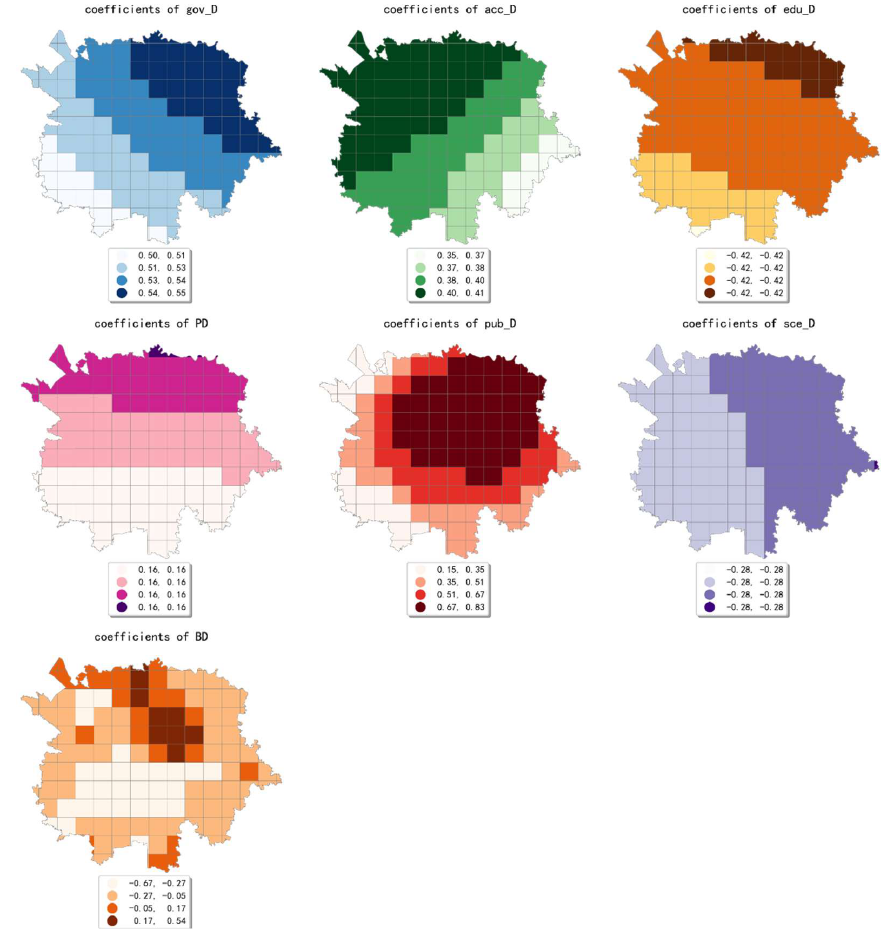
Figure 7. The estimated coefficient maps in the grid with 3000 m.